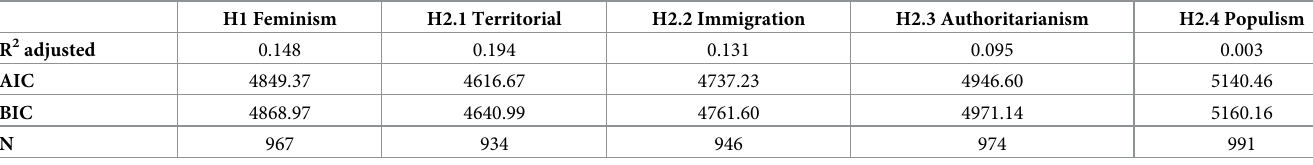
Table 2. R 2 adjusted, AIC and BIC for each model tested by Linear Regression.